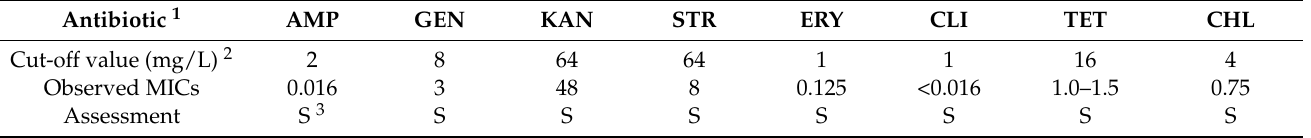
Table 5. Minimal inhibitory concentrations of L. reuteri KGC1901.